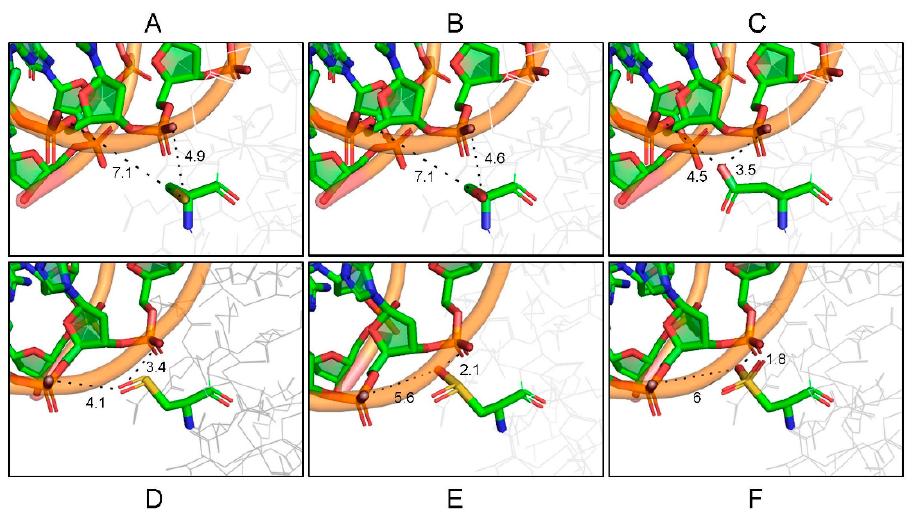
Figure 8. Modeling of different FixK 2 protein variants with the double-stranded DNA containing the FixK 2 box present at the fixNOQP promoter. Shown are the protein–DNA distances between the negatively charged oxygens of the phosphate group of the nitrogenous bases adenine 6 and adenine 7 of the strand W of DNA [23], and cysteine ( A ), serine ( B ), aspartic acid ( C ), cysteine–sulfenic acid ( D ), cysteine–sulfinic acid ( E ) and cysteine–sulfonic acid ( F ) residues of FixK 2 . The predictions of the 3D models of FixK 2 and C183D FixK 2 were obtained with the Pymol 2.2.3 program (https://pymol.org/2/; accessed on 13 October 2021), using the C183S FixK 2 –DNA structure as a template (http://wwpdb.org/; code 4I2O; accessed on 7 June 2021). Visualization of molecular structures and interactions was performed using the Discovery Studio Visualizer program, version V20.1.0.19295 (BIOVIA, Waltham, MA, USA), which also allowed the modeling of sulfenic, sulfinic and sulfonic acid derivatives of FixK 2 . Distances in angstroms (Å) are represented by dashed lines; adenine 6 on the left; adenine 7 on the right.